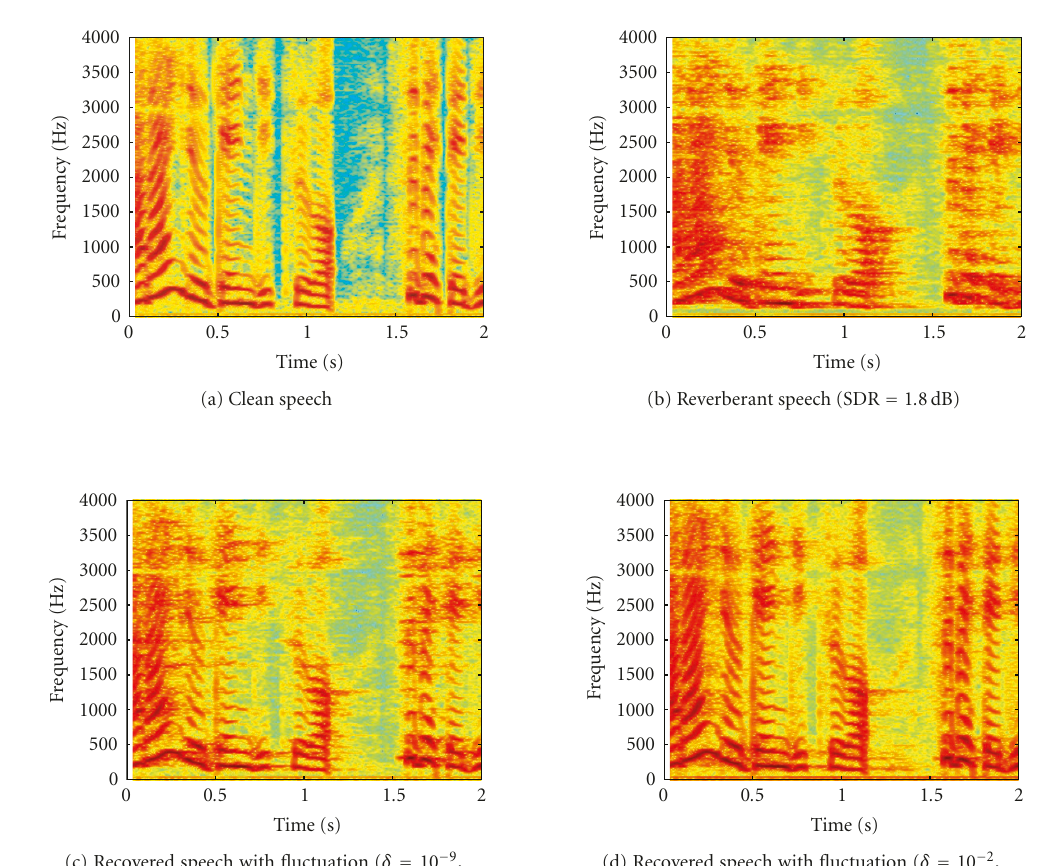
Figure 15: Spectrograms of speech